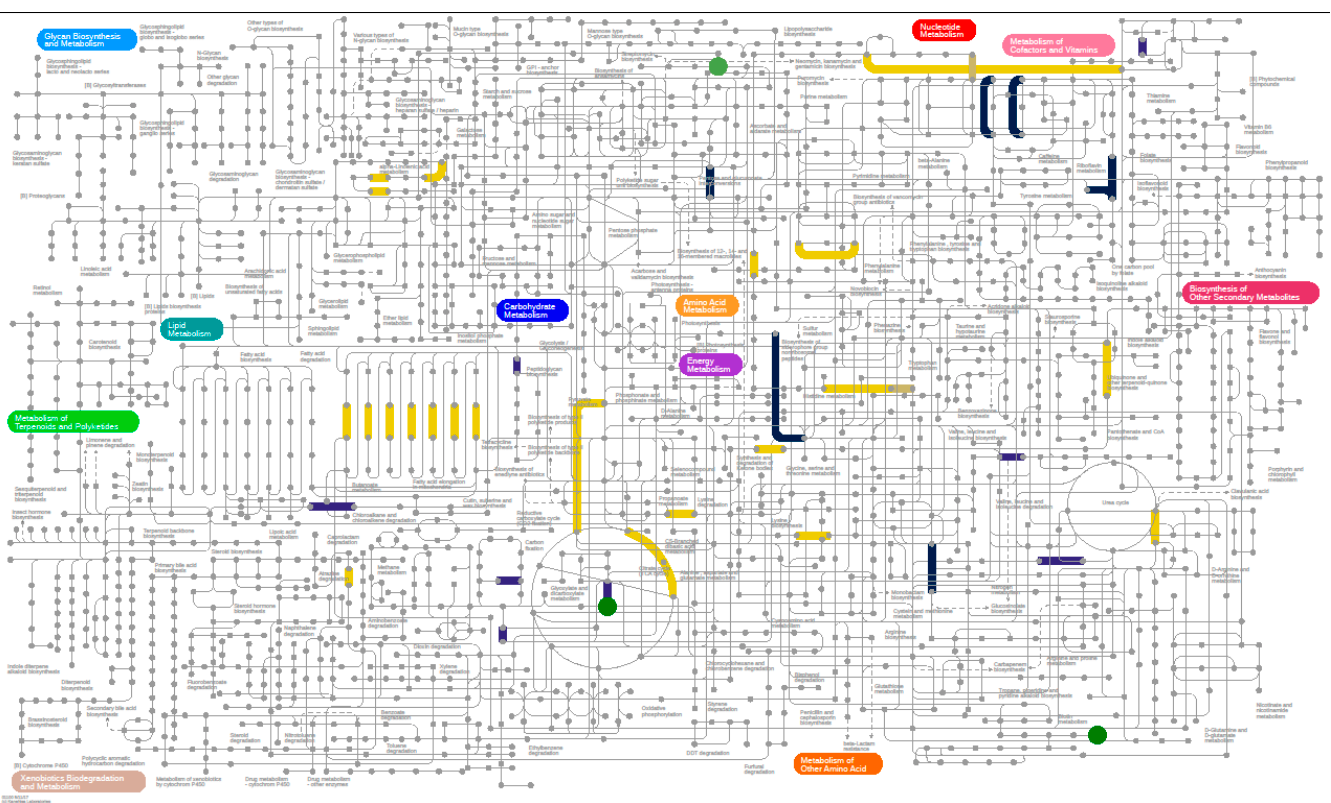
Figure 7. Functions and metabolites changing in abundance under the WF diet. For patients transitioned to the WF diet proteomics results, grouped by EC classification, from week 12 samples were compared against week 2 samples. Metabolites that increased over this time period are also highlighted (circles). Data is presented, as described in Figure 5. Interactive figures are available at https://pathways.embl.de/selection/lmukWBizoWD7FIQHot.